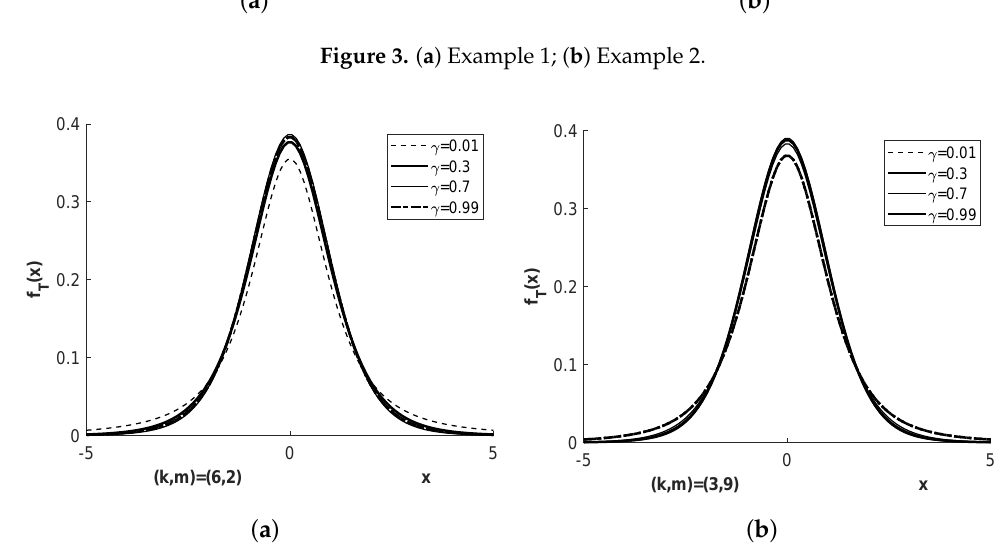
Figure 3. ( a ) Example 1; ( b ) Example 2.